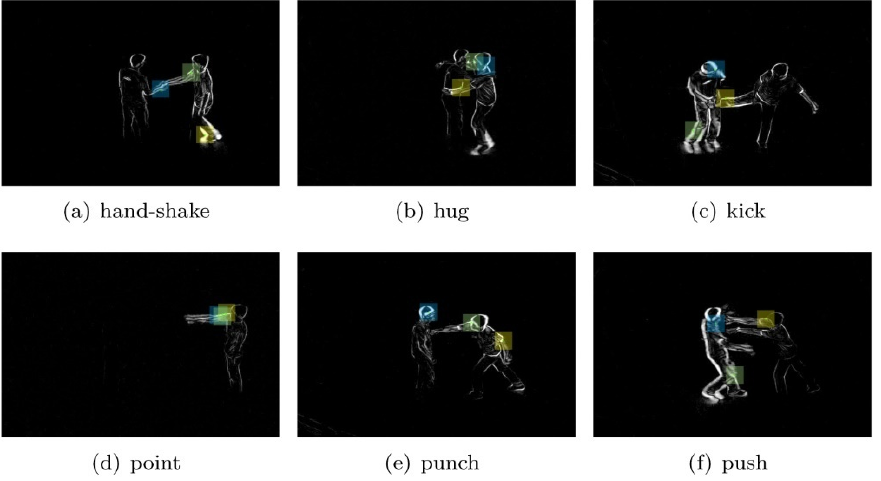
Figure 5. Cuboids generated around interest points for each action.